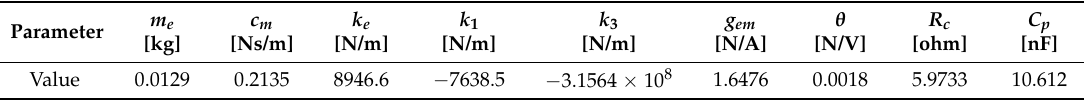
Table 3. Parameters of original differential equations for nonlinear hybrid energy harvester.